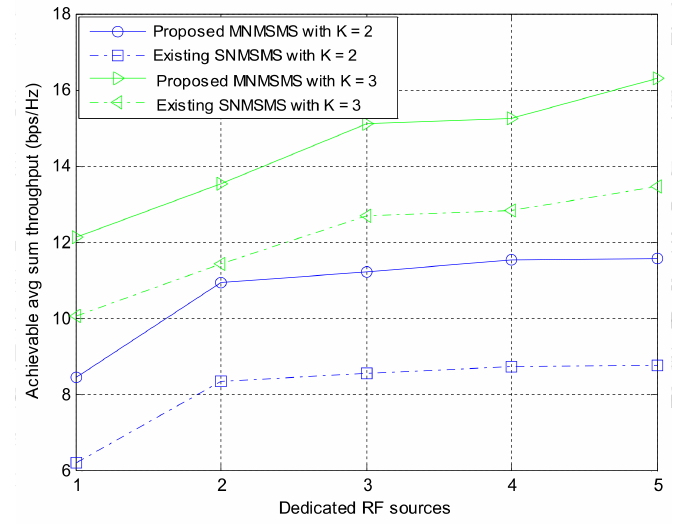
Figure 6. Achievable average sum-throughput against number of dedicated RF sources.